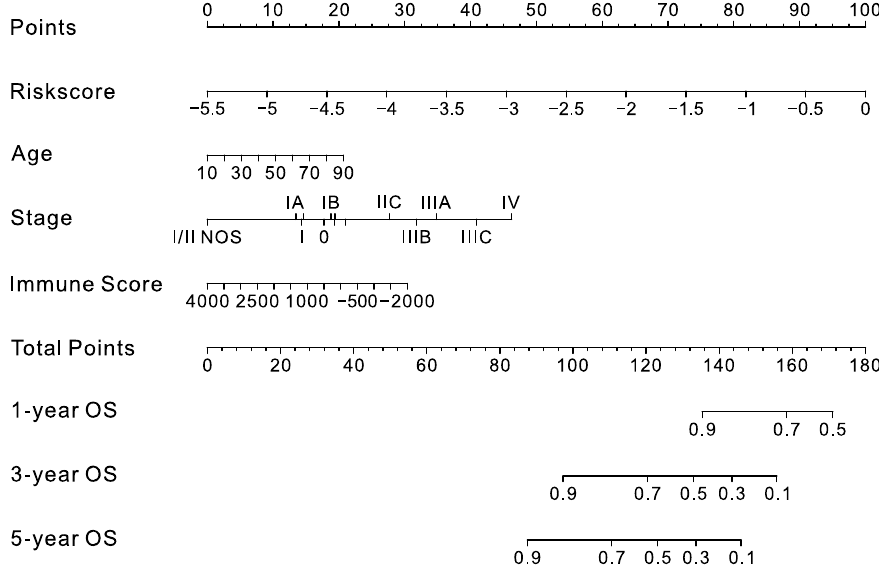
Figure 8. Nomogram for the prediction of OS in CM patients. The nomogram consisted of age, clin- ical stage, immune score, and the risk score. clinical stage, immune score, and the risk